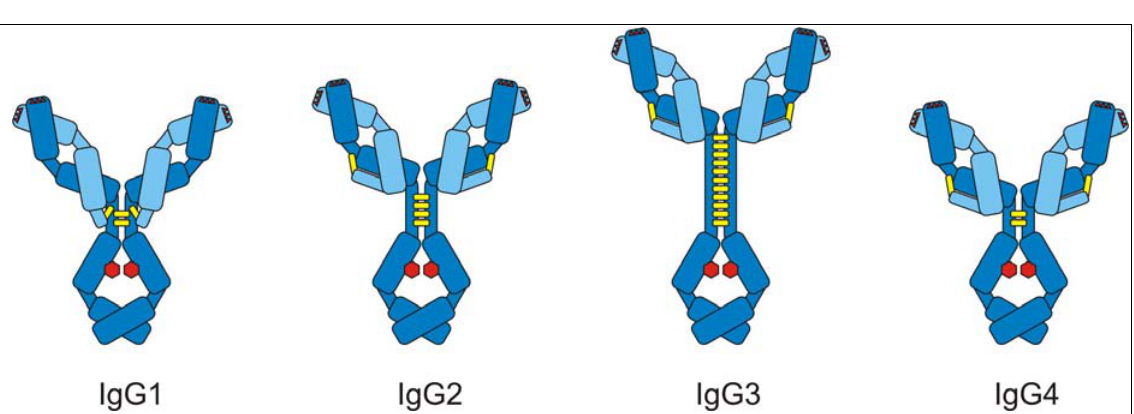
Figure 4. Schematic representation of the fully assembled, monomeric IgG molecules of all four human IgG subclasses. The molecules heavy-chains are indicated in dark-blue; the light-chains are indicated in light-blue; the inter-chain disulfide bonds are highlighted in yellow; complementarity-determining regions (CDR) are highlighted by red